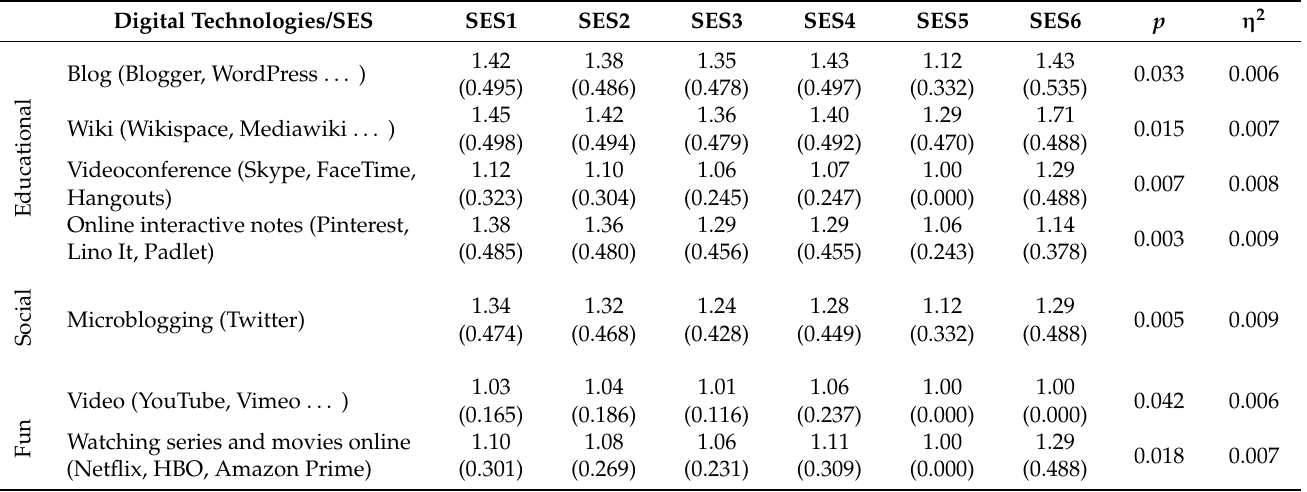
Table 4. Frequency of use according to the socioeconomic stratum (SES1 lower to SES6 higher) as a fixed factor.